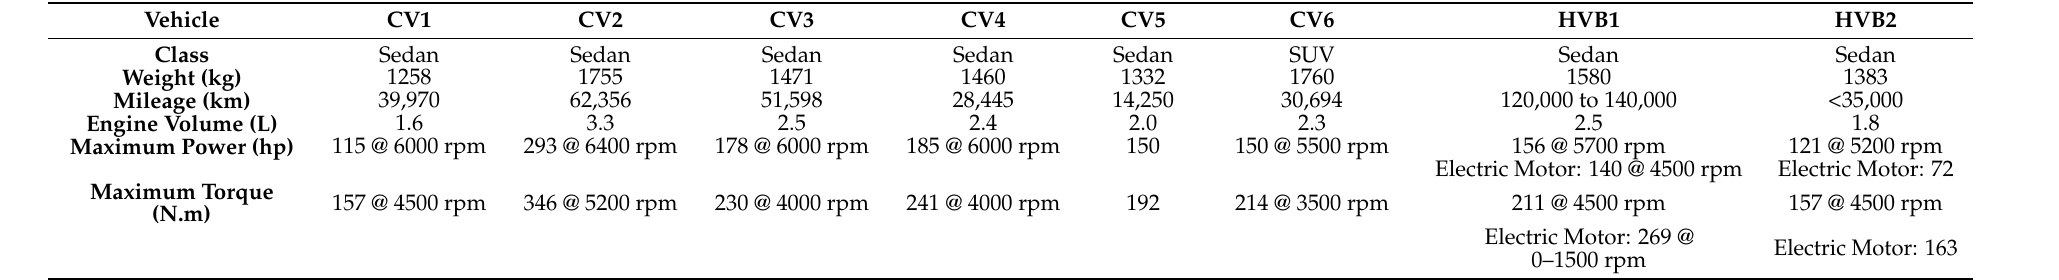
Table 2. Specifications of the investigated